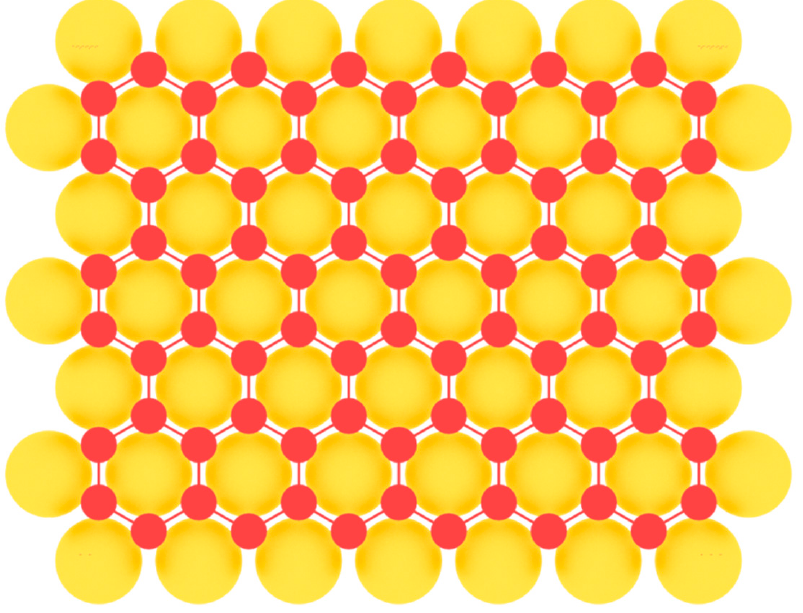
Figure 6. Model of borophene layer on a metal substrate.